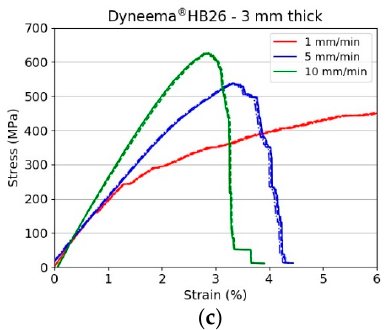
Figure 6. Stress vs. strain curves for Dyneema ® HB26 laminate with different thickness: ( a ) 10 mm; ( b ) 6 mm; ( c ) 3 mm.